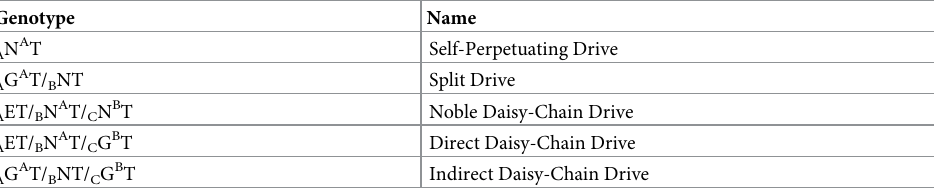
Table 1. Genotype specification of drive designs. Drives are listed in their heterozygous